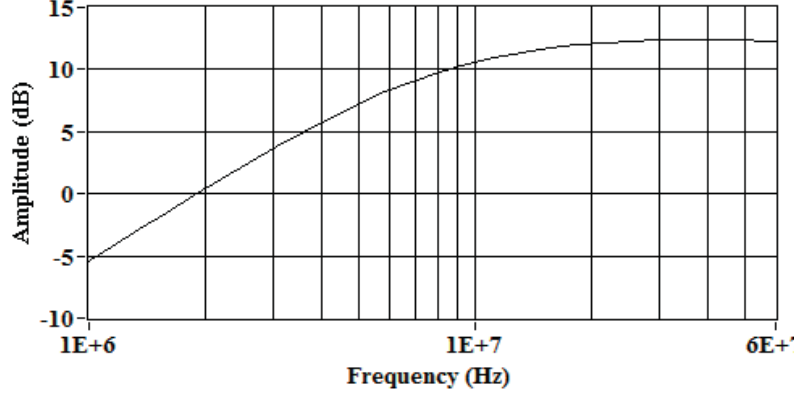
Figure 2. Frequency response of the Rogowski